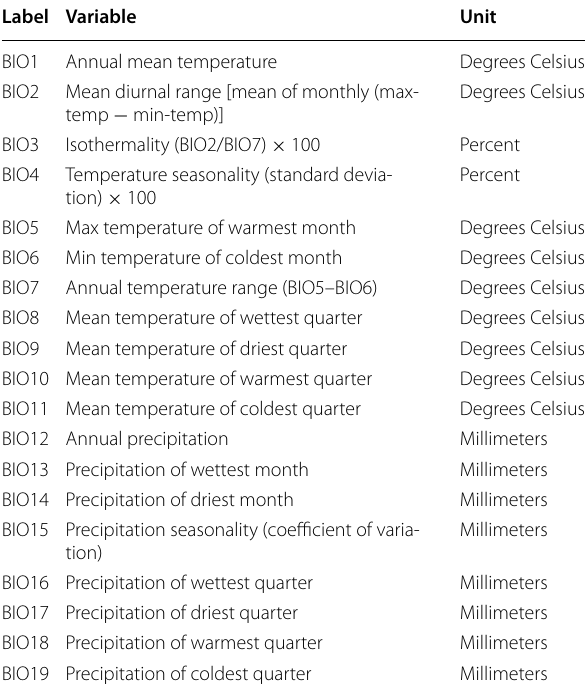
Table 1 Description of Bioclimatic variables